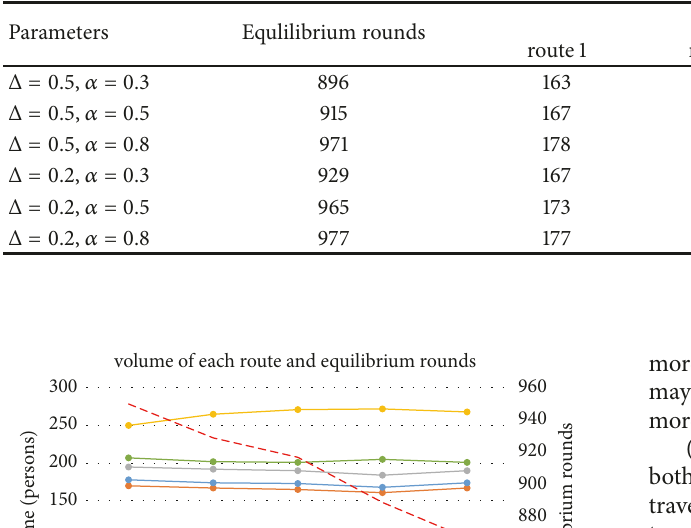
Table 3: Volume evolution of five routes for 𝑞 = 1000 , 𝜃 𝑖 = 0.2 .